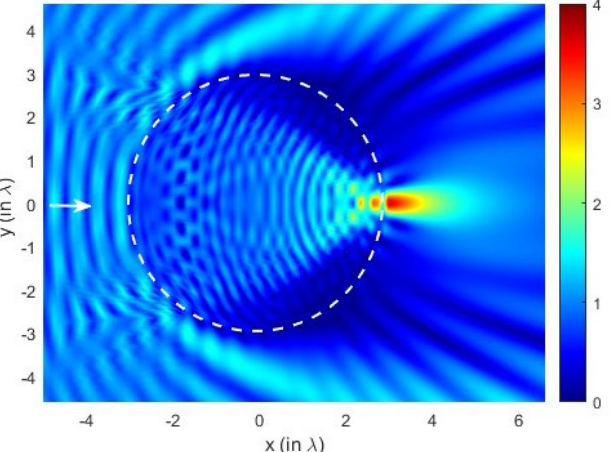
Figure 1. (Color online). The 2D intensity distribution of the Wave scattering on the sphere with diameter: R = 3 and m = 3. White arrow indicates the direction of incident plane wave while the dashed region represents the boundary of the sphere. The corresponding FWHM of the generated acoustojet is calculated as 0.51 λ